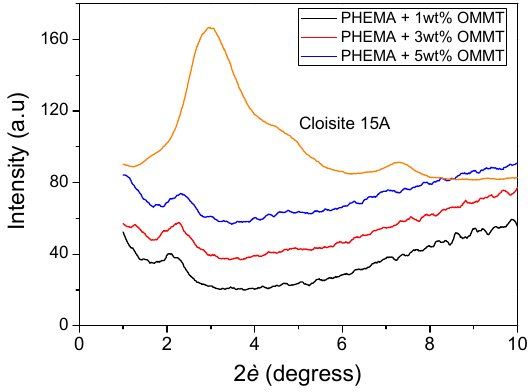
Figure 5. XRD diffraction patterns of the organomodified montmorillonite (OMMT) (Cloisite 15A) used and the PHEMA/OMMT